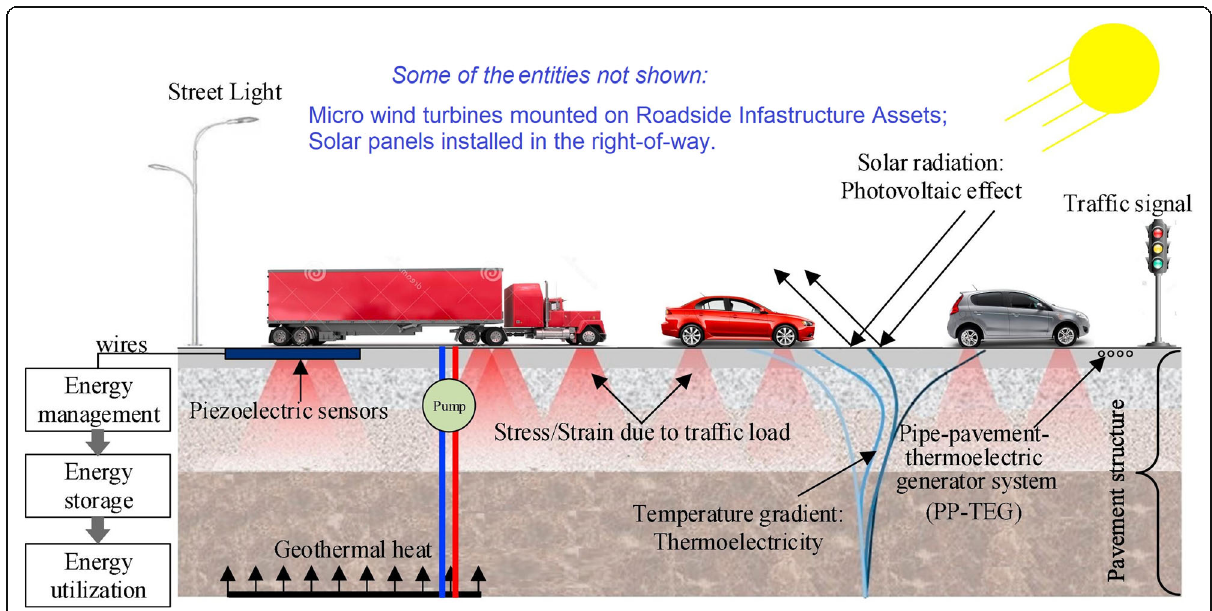
Fig. 3 Available on-road energy-harvesting technologies (modified from [39], courtsey of Elsevier)